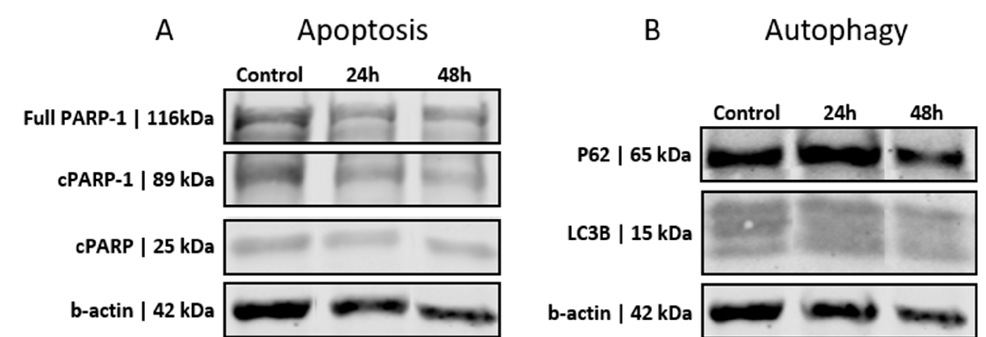
Figure 5. Western blot analysis of the apoptosis and autophagy biomarkers in BT-12 (cultured in stem cell conditions) GSCs treated with 10 µg/mL PEI-MSNs for 24 h and 48 h. ( A ) Expression levels of apoptotic biomarkers of the full-length PARP-1 and cPARP (89 kDA and 25 kDA). ( B ) Expression levels autophagy biomarkers P62 and LC3B (The original western blot figures are shown in File S1).